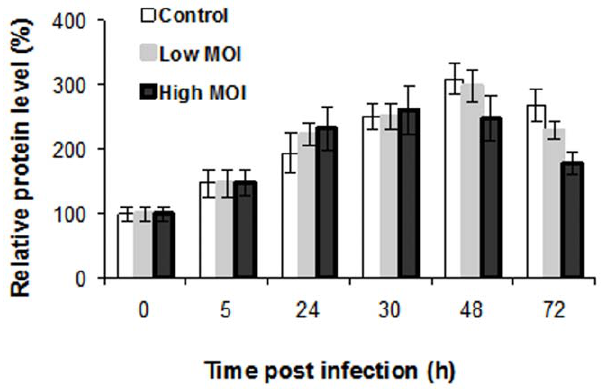
Figure 3. Total level of cellular proteins in RVFV-infected HSAECs. Slides stained with Sypro Ruby and normalized relative to uninfected HSAECs at 0 h.p.i. Each sample of 40 cells per dot along with seven 2 6 serial dilutions was printed in duplicate. Black and gray bars illustrate the MOI of 0.002 and 0.0002, correspondingly. Data represent mean values and confidence intervals of two-tail t-test ( a =0.05, n =3).